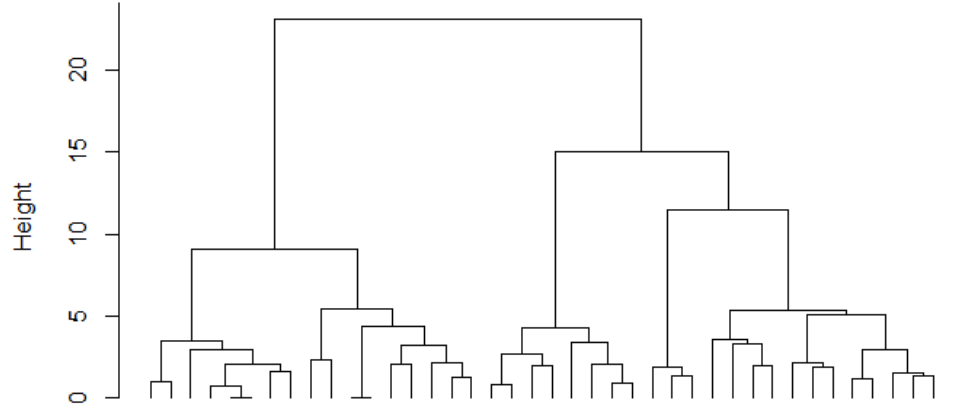
Figure 6. Dendrogram of all observations.